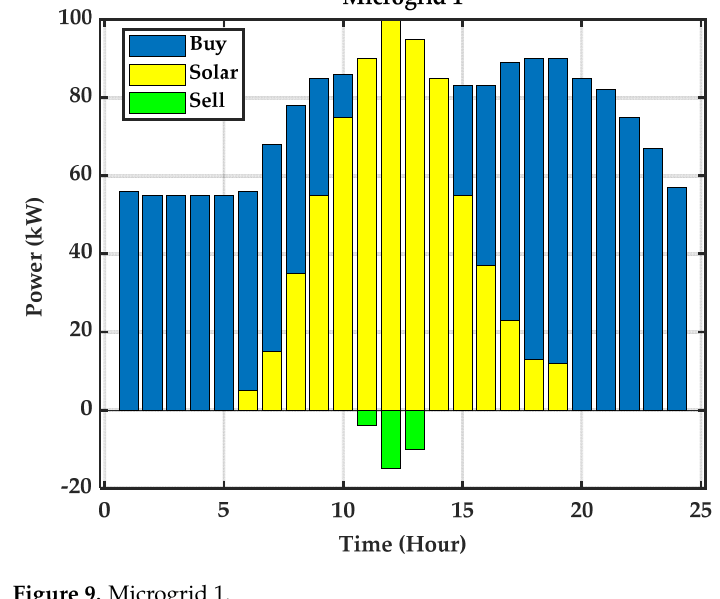
Figure 9. Microgrid 1.